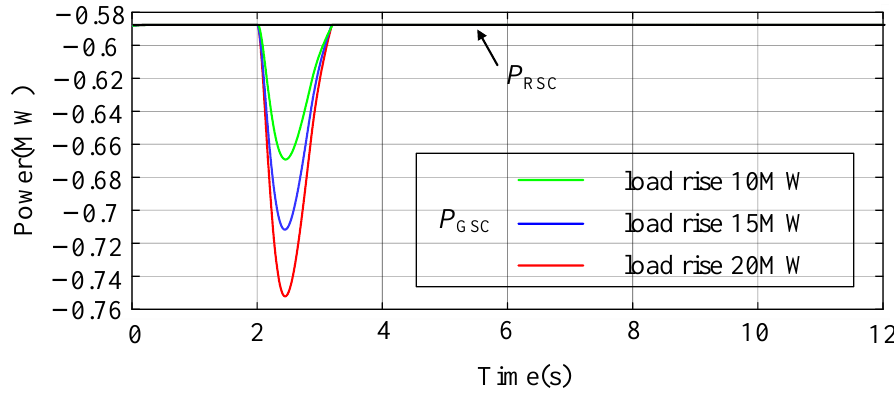
Figure 26. GSC and RSC running status curves of DFIG at high wind speed.